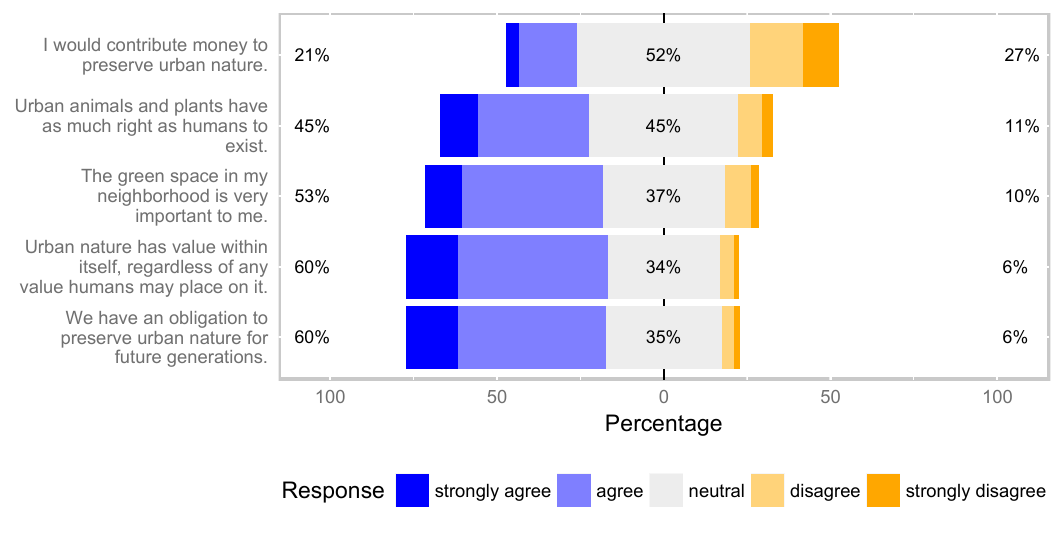
Figure 3. Respondents’ attitude toward urban nature.